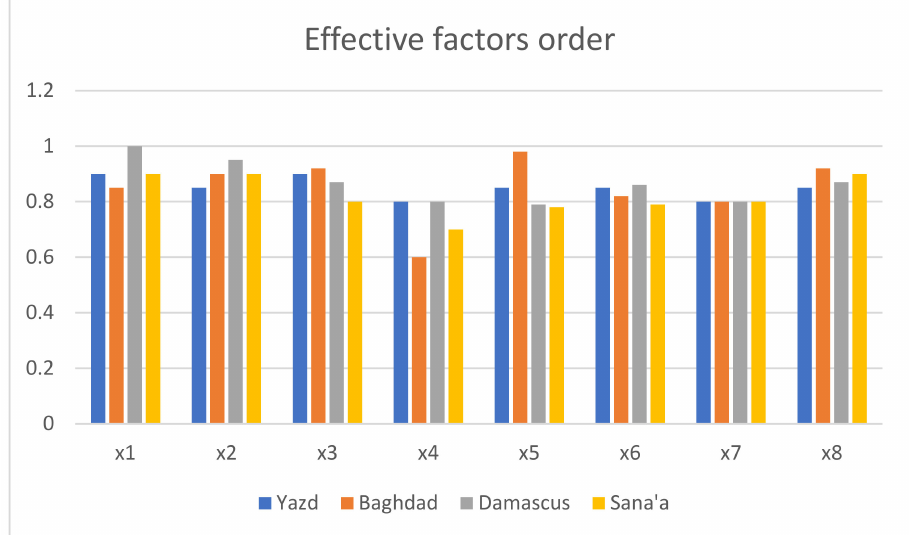
Figure 11. Effective indictors’ ratio for the four case study